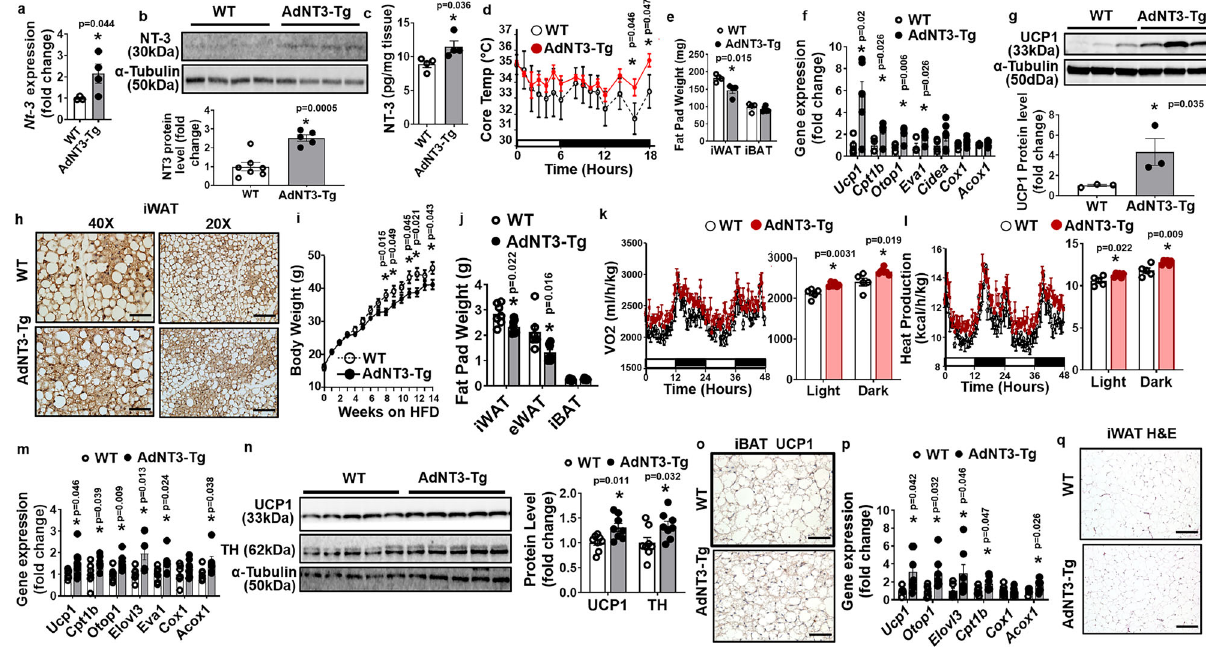
Fig. 3 Overexpression of NT-3 in adipocytes promotes cold-induced thermogenesis and protects mice from diet-induced obesity. a – c Nt-3 mRNA ( a , WT n = 3, AdNT3-Tg n = 4, * indicates statistical signi fi cance between WT and AdNT3-Tg with unpaired two-tailed t test), NT-3 protein levels measured by immunoblotting ( b , WT n = 7, AdNT3-Tg n = 5, * indicates statistical signi fi cance between WT and AdNT3-Tg with unpaired two-tailed t test) and ELISA ( c , n = 4/group, * indicates statistical signi fi cance between WT and AdNT3-Tg with unpaired two-tailed t test) in iWAT of WT and AdNT3-Tg mice. d – h Core body temperature ( d , n = 5/group, * indicates statistical signi fi cance between WT and AdNT3-Tg with unpaired two-tailed t test), fat pad mass ( e , n = 4/group, * indicates statistical signi fi cance between WT and AdNT3-Tg with unpaired two-tailed t test), Ucp1 and other thermogenic gene expression in iWAT ( f , WT n = 4, AdNTF3-Tg n = 6, * indicates statistical signi fi cance between WT and AdNT3-Tg with unpaired two-tailed t test), UCP1 protein levels in iWAT ( g , n = 3, *indicates statistical signi fi cance between WT and AdNT3-Tg with unpaired two-tailed t test), and representative UCP1 immunostaining images showing UCP1- positive beige adipocytes in iWAT ( h , from three replicate animals/group, Scale bar for the ×40 images = 75 µ m, and for the ×20 images = 150 µ m) of AdNT3- Tg mice and their littermates during cold exposure. i – l Body weight ( i , WT n = 8, AdNT3-Tg n = 10, * indicates statistical signi fi cance between WT and AdNT3- Tg with unpaired two-tailed t test), fat pad mass ( j , n = 7/group, * indicates statistical signi fi cance between WT and AdNT3-Tg with unpaired two-tailed t test), Oxygen consumption ( k , WT n = 5, AdNT3-Tg n = 6, * indicates statistical signi fi cance between WT and AdNT3-Tg with unpaired two-tailed t test) and heat production ( l , WT n = 5, AdNT3-Tg n = 6, * indicates statistical signi fi cance between WT and AdNT3-Tg with unpaired two-tailed t test) in AdNT3-Tg mice and their littermate controls fed with HFD starting 6 weeks of age. m – o ) Ucp1 and other thermogenic gene expression ( m , WT n = 7, AdNTF3-Tg n = 8, * indicates statistical signi fi cance between WT and AdNT3-Tg with unpaired two-tailed t test), UCP1 and TH protein levels ( n , n = 8/group, * indicates statistical signi fi cance between WT and AdNT3-Tg with unpaired two-tailed t test), and representative UCP1 immunostaining in iBAT ( o , from three replicate animals/group, scale bar = 75 µ m) of AdNT3-Tg mice and their littermate controls fed HFD. p , q Ucp1 and other thermogenic gene expression ( p , WT n = 6, AdNTF3-Tg n = 7, * indicates statistical signi fi cance between WT and AdNT3-Tg with unpaired two-tailed t test), and H&E staining ( q , from three replicate animals/group, scale bar = 150 µ m) in iWAT of AdNT3-Tg mice and their littermate controls fed a HFD. All data are expressed as